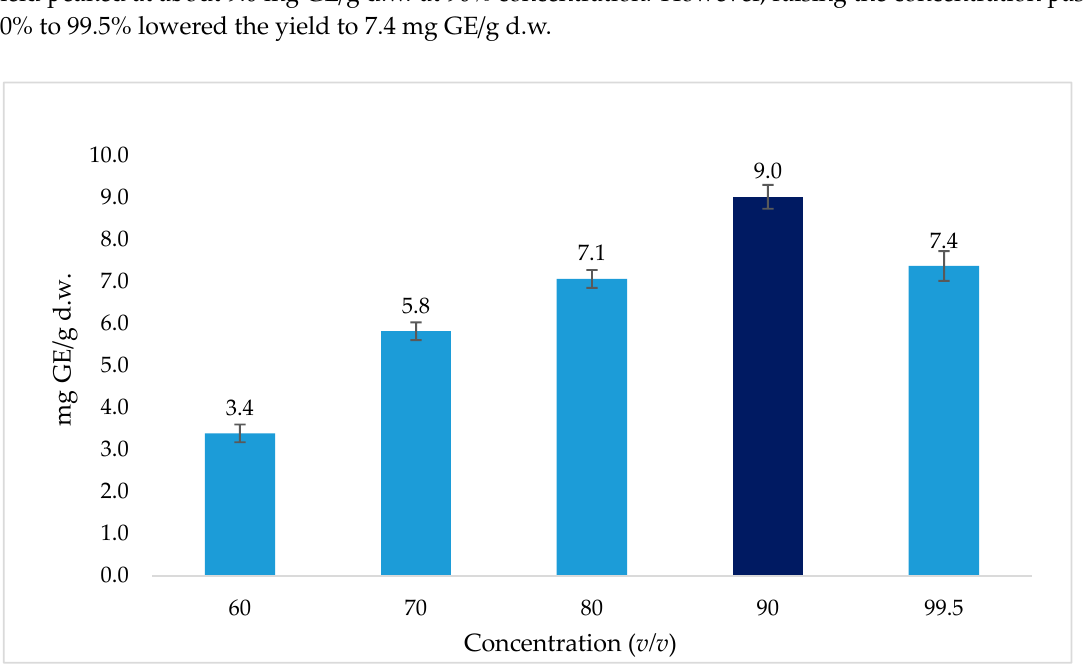
Figure 2. Effect of ethanol concentration. Figure 2. E ff ect of ethanol